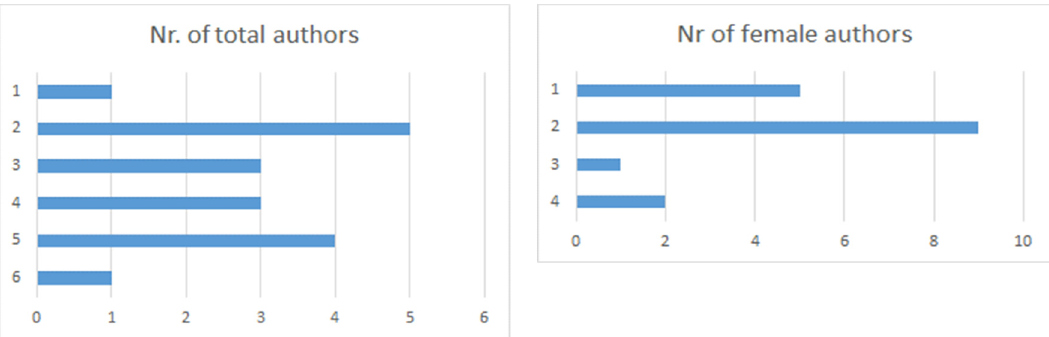
Figure 4. Distribution of the papers according to the number of authors ( left ); Distribution of the papers according to the number of female authors ( right ). papers according to the number of female authors ( right ).